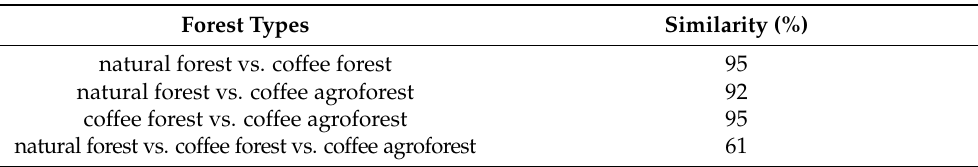
Table 2. Sorensen and Multiple Site Similarity index of woody species among the natural forest, coffee forest and coffee agroforest.